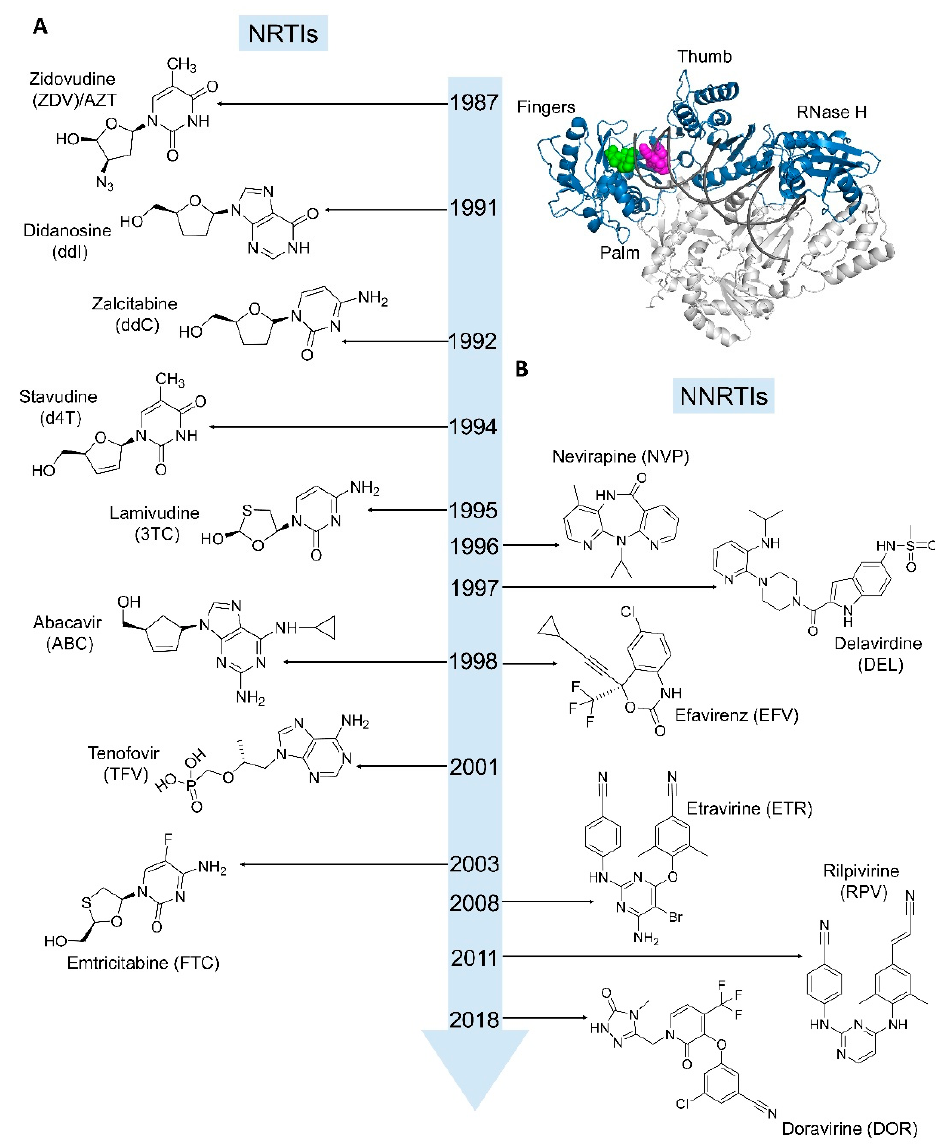
Figure 2. Timeline of HIV-1 RT-inhibiting drugs approved for clinical use. ( A ) The nucleoside/nucleotide analogs (NRTIs) act as DNA chain terminators. ( B ) NNRTIs bind to a pocket away from the polymerase active site and allosterically inhibit RT. Binding sites for dNTP/NRTI-TP (green) and NNRTI (magenta) in the p66 subunit (blue) of RT are shown on the top right panel. The p51 subunit is in gray.